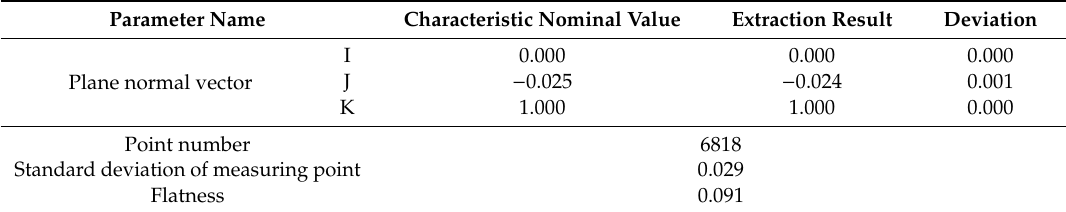
Table 5. Supporting block plane parameter extraction result (mm).